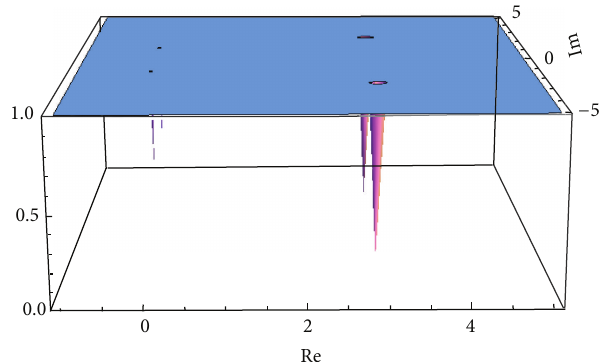
Figure 15: Stability function of the only attractive strange fixed point of Z8.